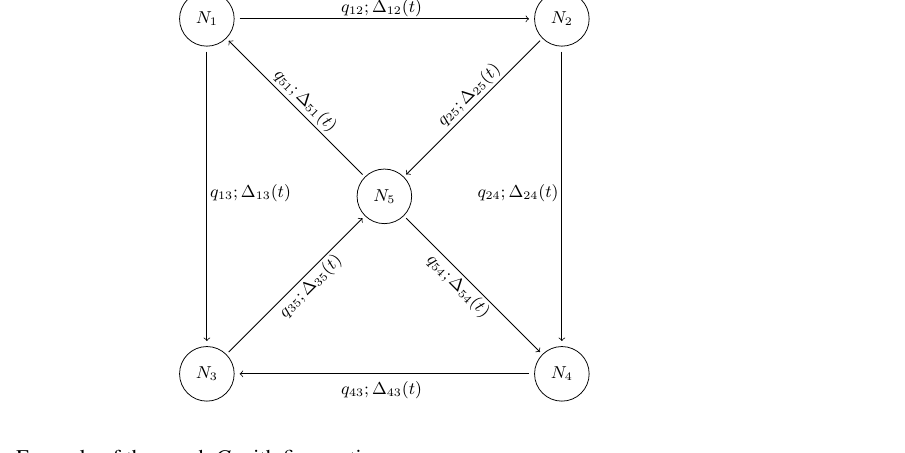
1 Figure 1. Example of the graph G with five